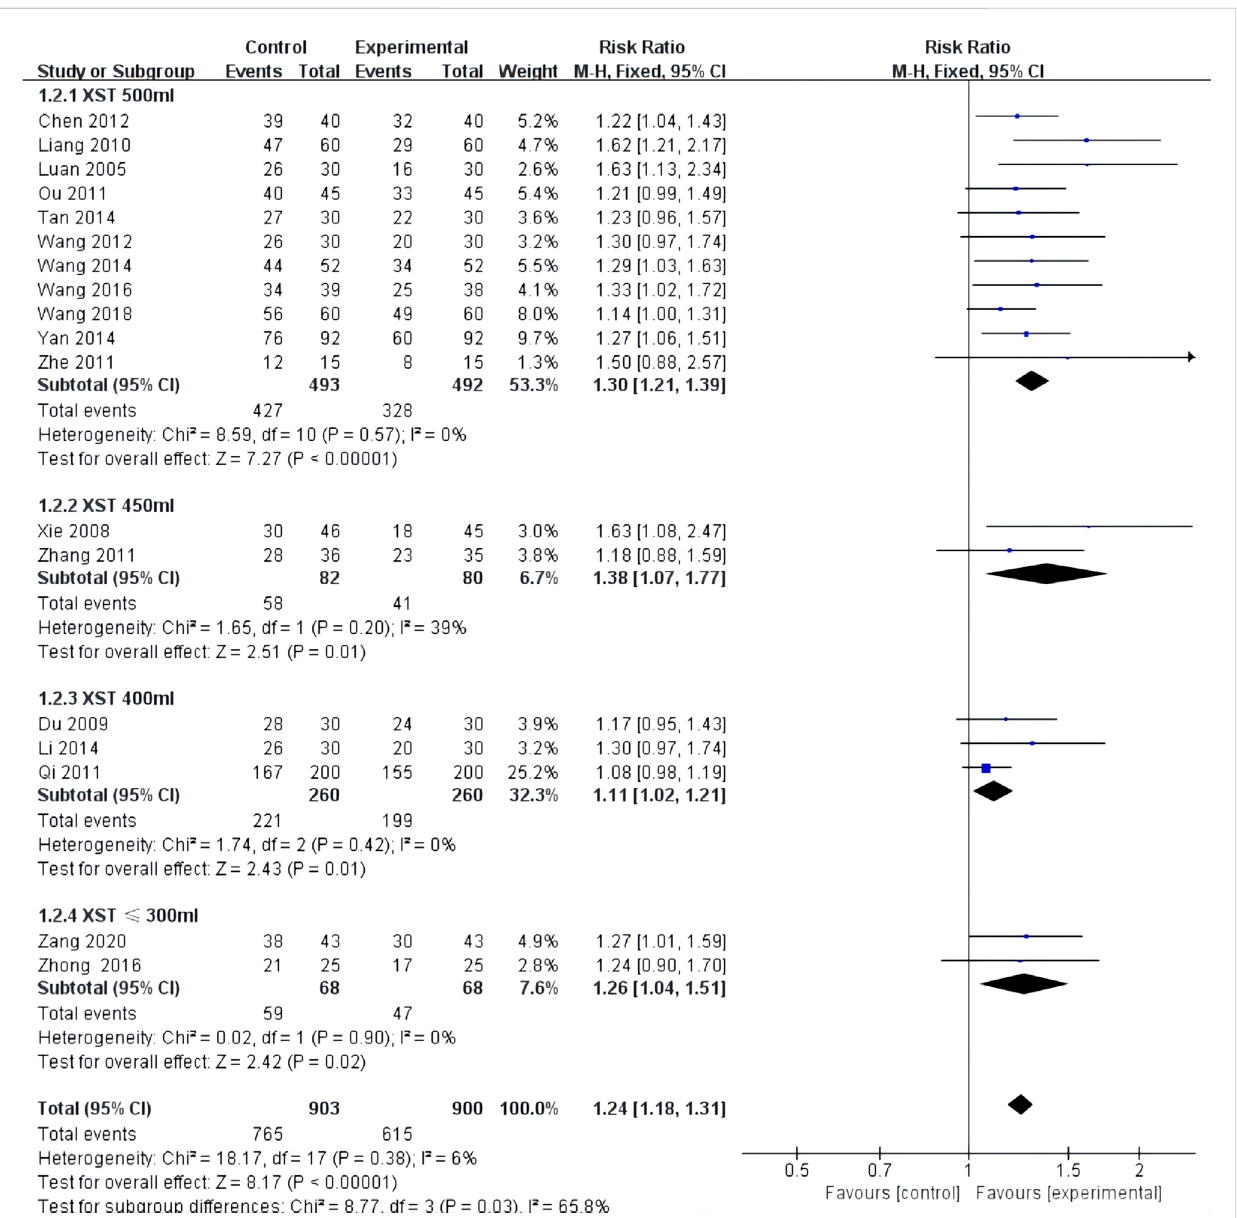
FIGURE 4 Forest plot of ECG